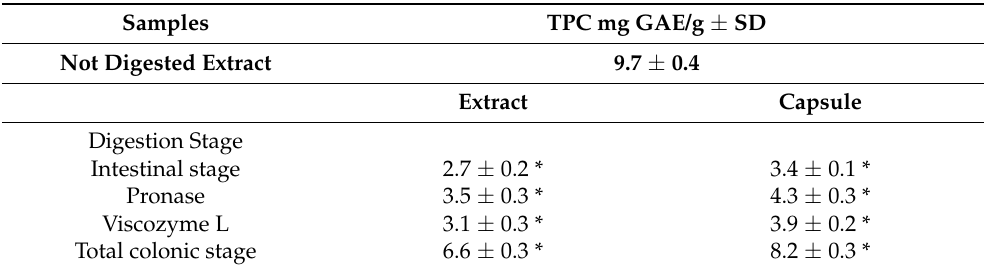
Table 3. Total phenolic content measured in encapsulated and non-encapsulated broad bean hull extract.